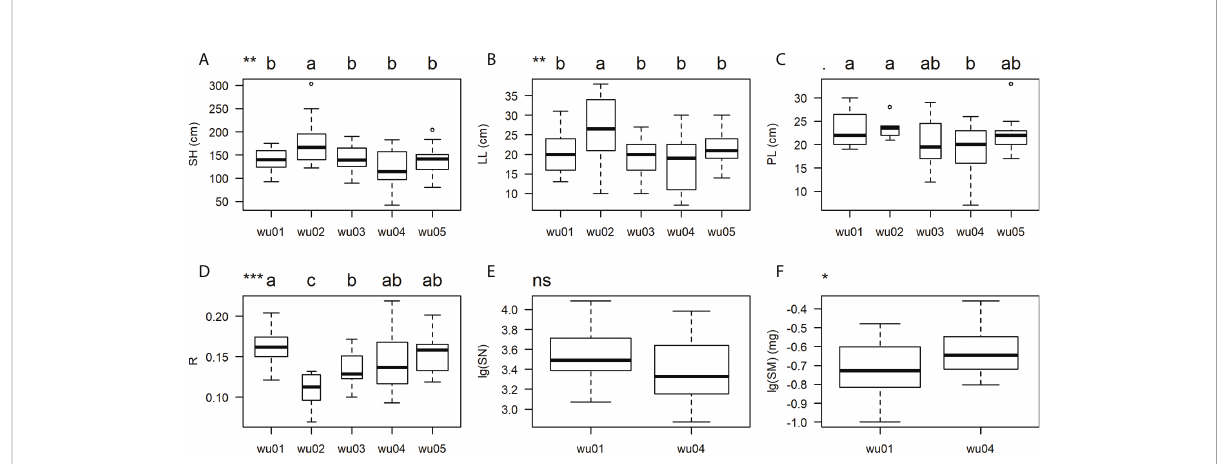
FIGURE 2 Plant functional traits ( A , shoot height; B , leaf length; C , panicle length; D , reproductive allocation, i.e., the ratio of panicle length to shoot height; E , log-transformed seed number per panicle; F , log-transformed mass per seed) of Phragmites australis from different populations. Different letters represent signi fi cant differences. In the box diagram, the middle horizontal line is the median, and the box frame is the interquartile distance ( IQR ). Each whisker extends to the furthest data point in each wing that is within 1.5 times the IQR , data points further than 1.5 IQR are marked with a dot. ns represents no signi fi cance; · P < 0.1; * P < 0.05; ** P < 0.01; *** P <